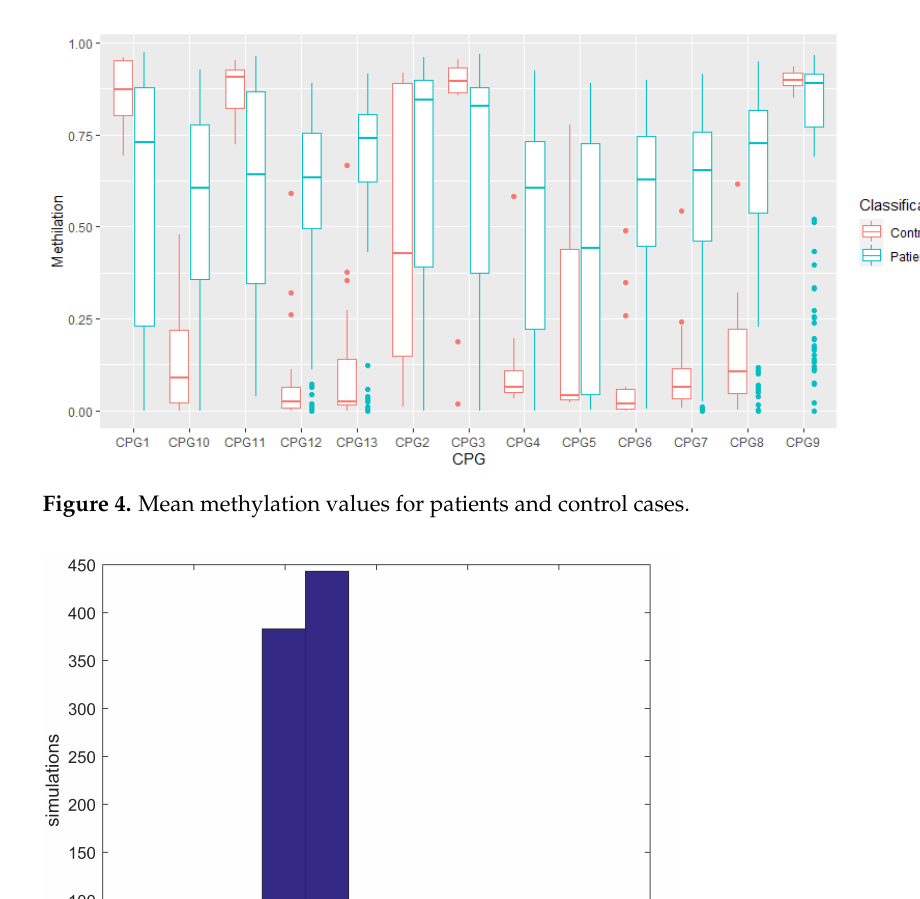
Figure 3. Accuracy obtained using Algorithm 1 (grid approach varying the number of neurons and α factor in a grid).